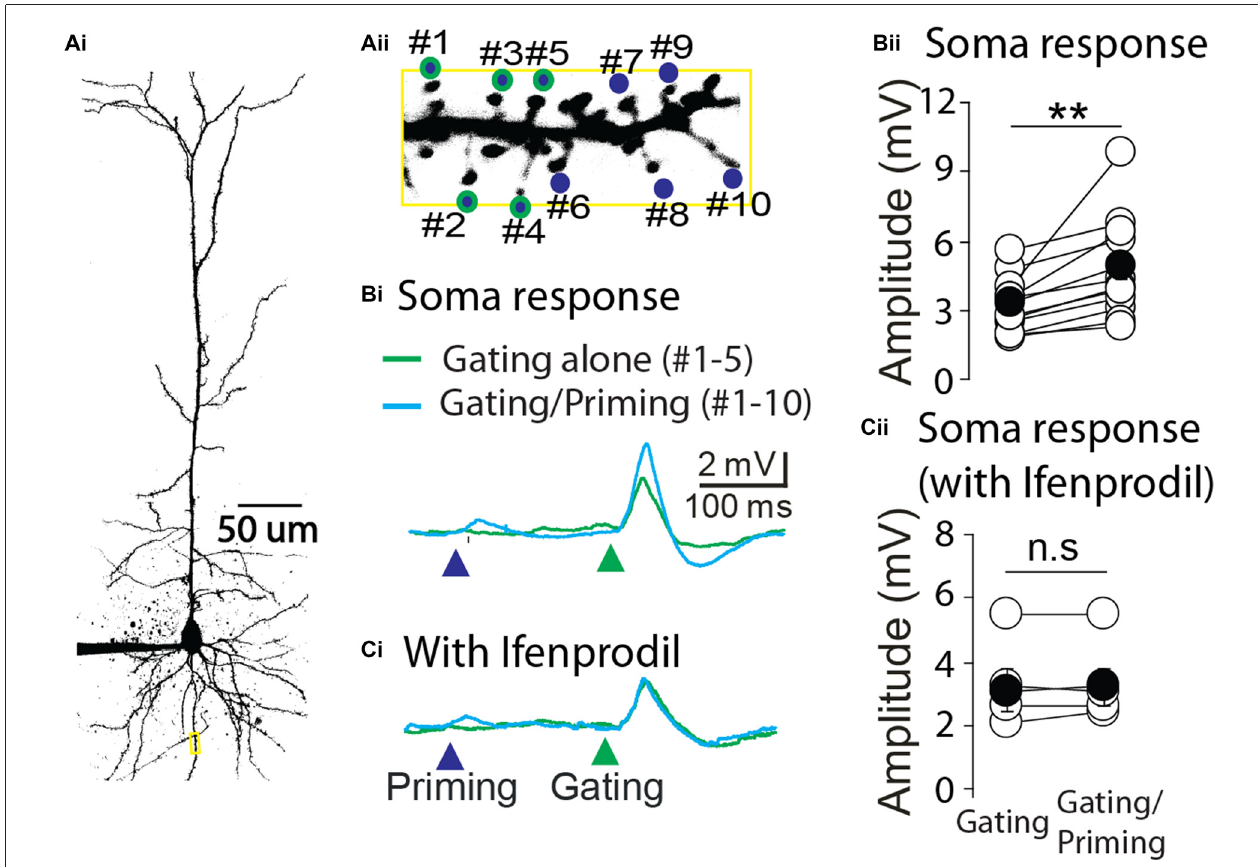
FIGURE 5 | Cortical STPP. (A) Two photon image of a pyramidal neuron (Ai) and its basal dendrite with priming (blue color)/gating (green outline) glutamate uncaging spots on the individual spines in a basal dendrite (Aii) . (B) The representative responses to priming plus gating (cyan trace) and gating alone (green trace) glutamate uncaging were shown as photoactivated EPSPs. When the priming stimulus preceded the gating stimulus, the facilitated response (cyan trace) was elicited in the electrical recording at the cell body (Bi) . (C) NR2B selective blocker, Ifenprodil, completely blocked the neuronal facilitation (Ci) . Population data of control ( Bii , n = 12 cells/4 animals) and Ifenprodil ( Cii , n = 5 cells/4 animals) in electrical recording of the cell body. ∗∗ p < 0.01; n.s, P >